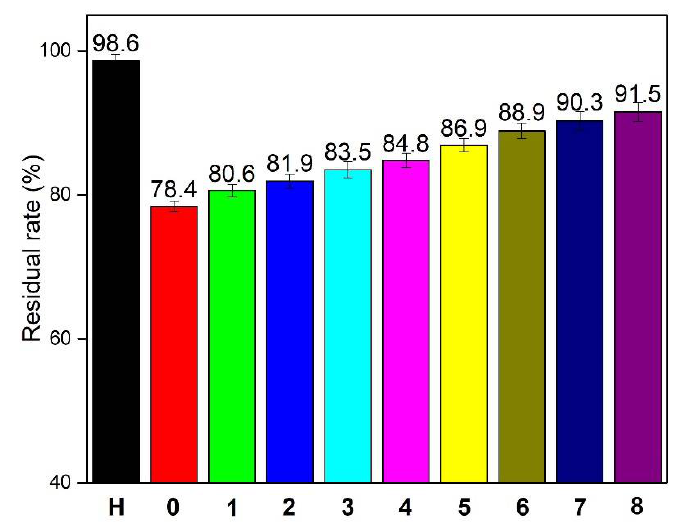
Figure 6. Residual rates of SF adhesives with different amounts of HMP additives: H (HMP adhesive), 0 (SF adhesive), 1 (SF/3% HMP adhesive), 2 (SF/6% HMP adhesive), 3 (SF/9% HMP adhesive), 4 (SF/12% HMP adhesive), 5 (SF/15% HMP adhesive), 6 (SF/18% HMP adhesive), 7 (SF/21% HMP adhesive), and 8 (SF/24% HMP adhesive).